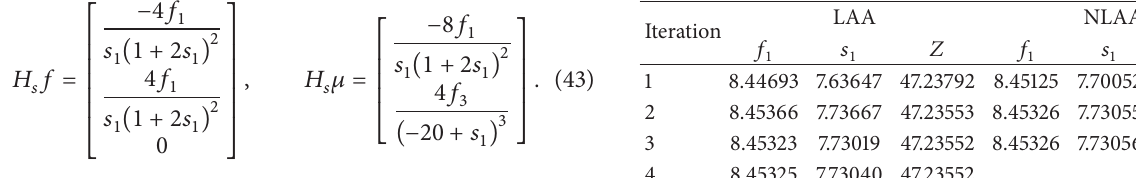
Table 2: Computational results of LAA and NLAA in Example